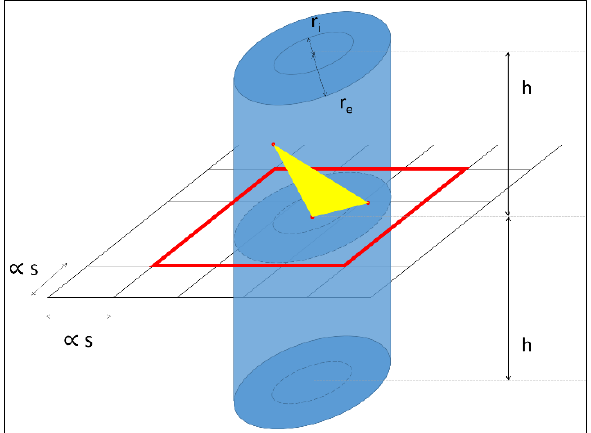
Figure 2. Criteria and parameters of adaptive meshing and matching iterative process.